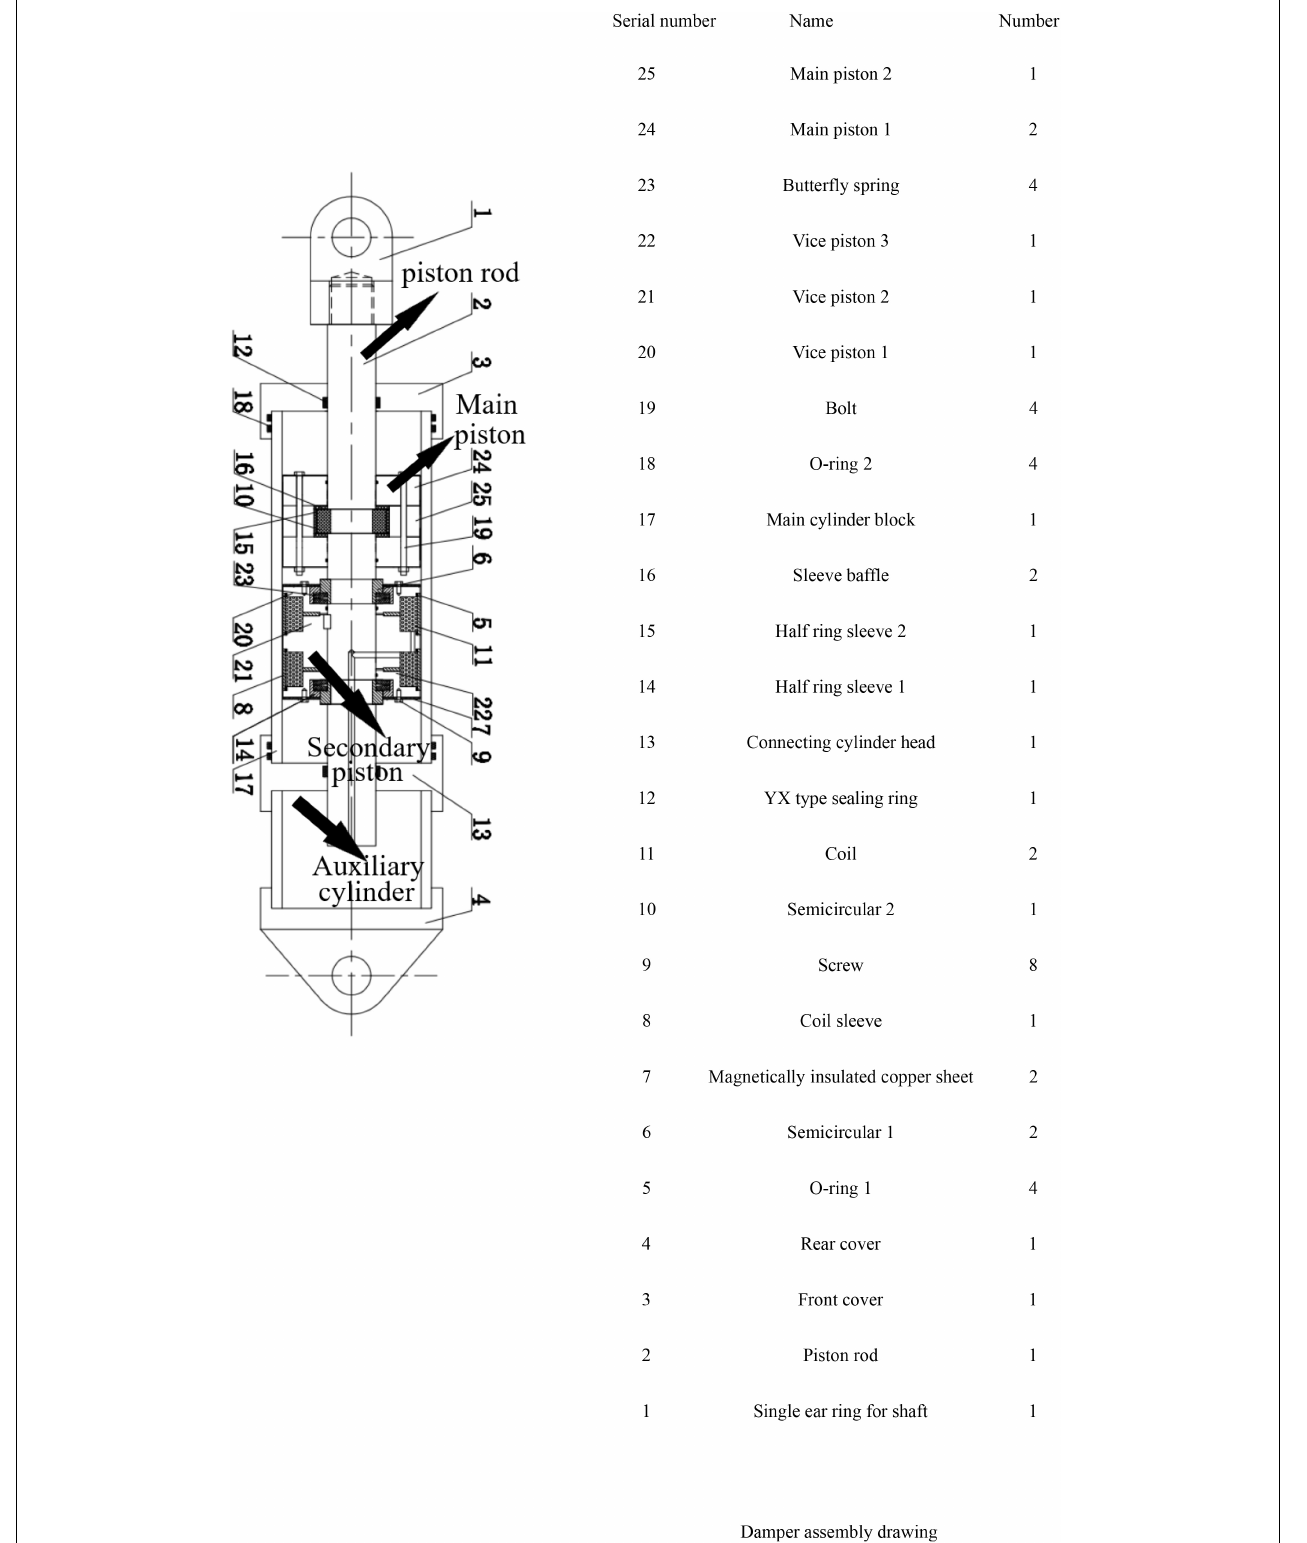
FIGURE 2 | Structural form of the